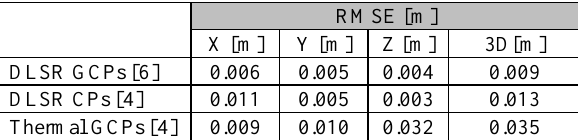
Table 3. Mean errors on GCPs for DLSR camera dataset and thermal dataset.